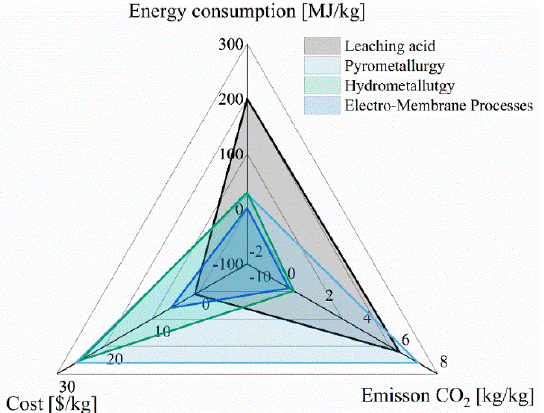
Figure 7. Economic analysis for methods of recycling of LIBs.